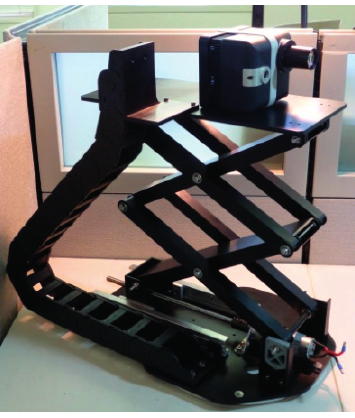
Figure 10. Completed scissor lift assembly with the 3D Flash LIDAR camera at the